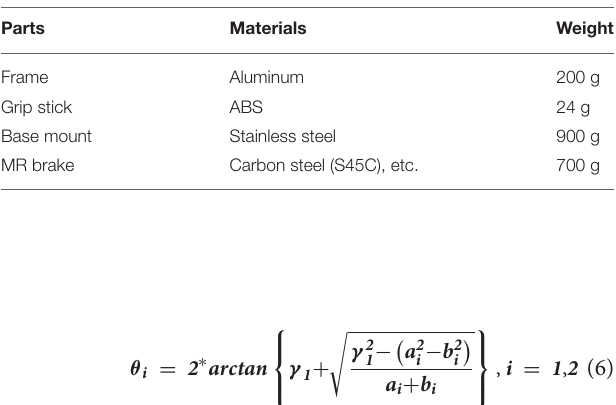
TABLE 2 | Components of the MR Brake and their